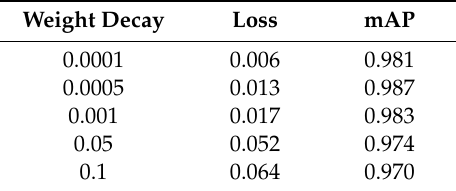
Table 7. Weight attenuation coe ffi cient test results.